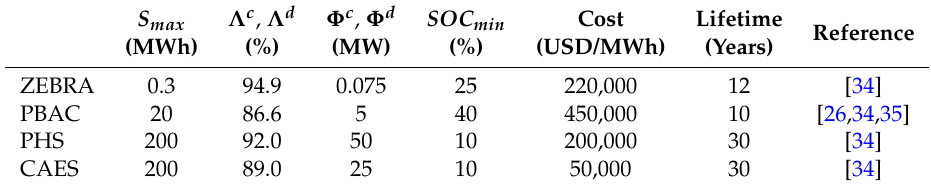
Table 2. Different technologies for ESS that we consider in this work. ZEBRA, Zeolite Battery